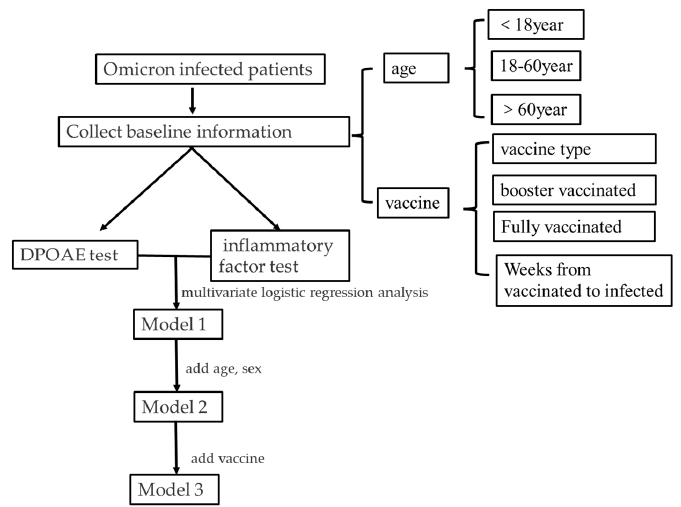
Figure 1. A schematic diagram for the article. DPOAE: Distortion Product Otoacoustic Emission.